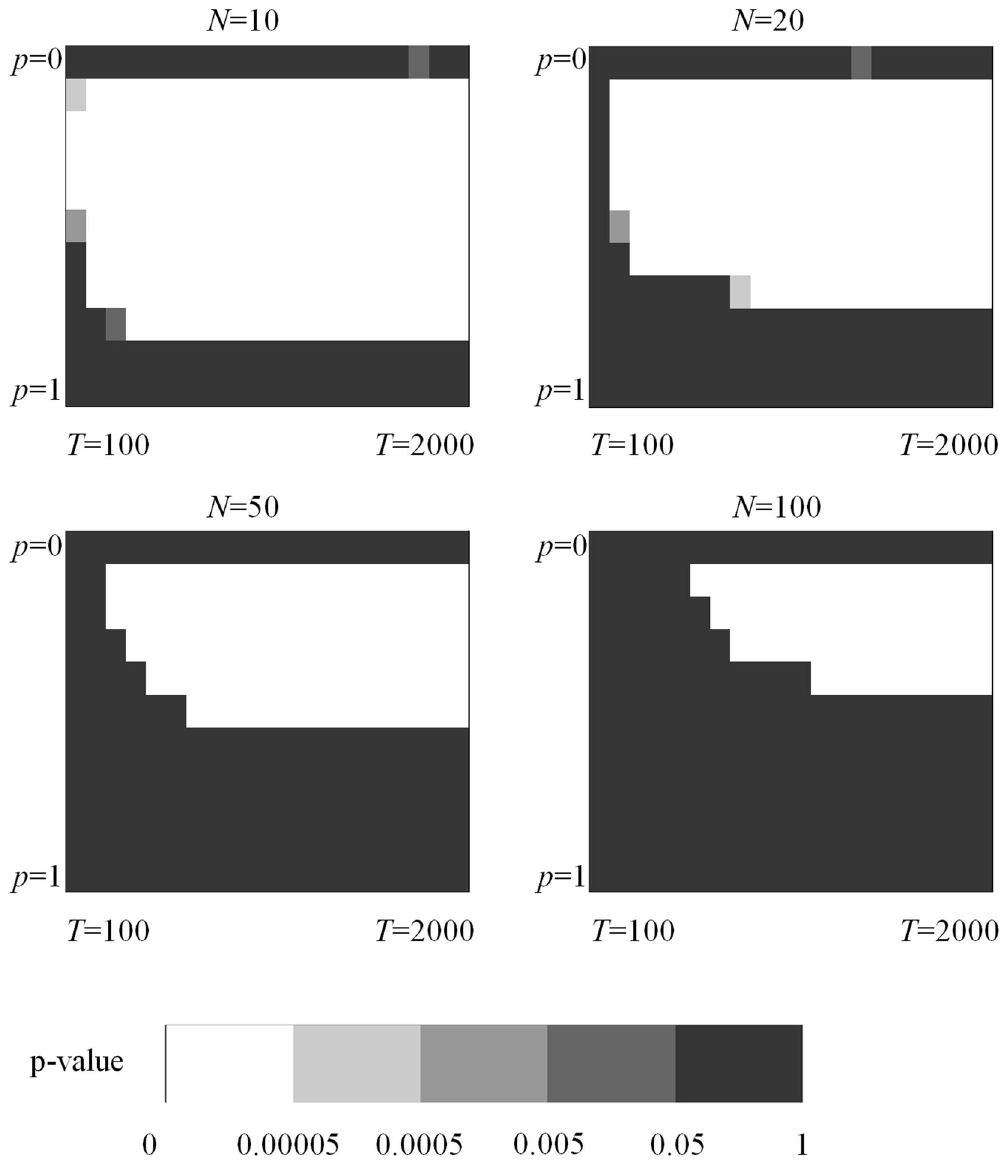
Fig. 8 The effect of the number of actor N on model behavior. Explanation of the fi gure is exactly the same as in Fig. 4. In general, more non-black squares appear as N decreases, implying social behavior is favored. Values for other parameters are: D = 0.002 , M = 1000, Q = 1, S = 1, E =